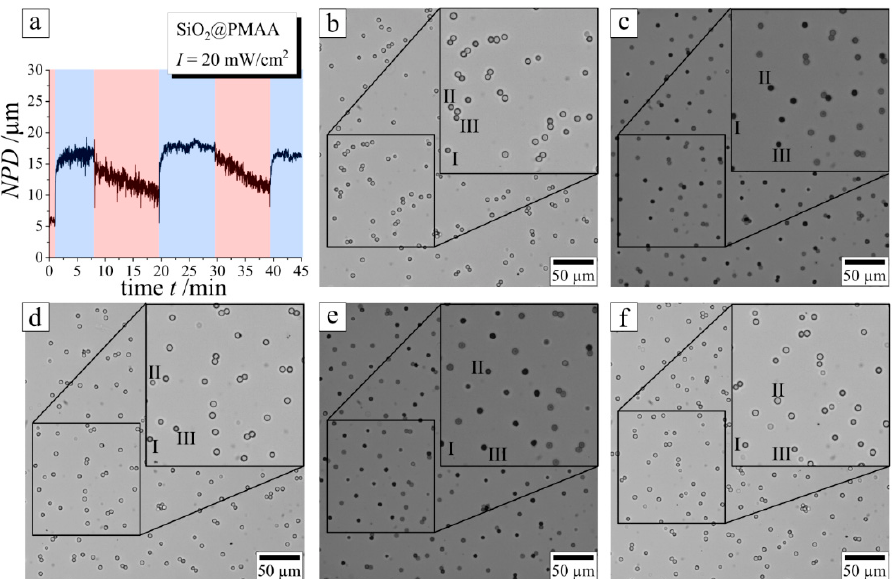
Figure 2. ( a ) Nearest particle distance (NPD) as a function of the irradiation wavelength and time. Red (625 nm) and blue (455 nm, I = 20 mW/cm 2 ) color illustrates the illumination wavelength; ( b – f ) snapshots of optical micrographs taken at different irradiation steps: ( b ) at the end of particle aggregation under red illumination (1 min), ( c ) end of particle separation under blue illumination (5 min), ( d ) slow particle aggregation at 15 min, ( e ) fully separated state under blue illumination (25 min), ( f ) slow particle aggregation during the second cycle (39 min). The corresponding video is provided in Video S1, Supporting Information. Roman numbers I–III illustrate particle position at different recorded optical micrograph